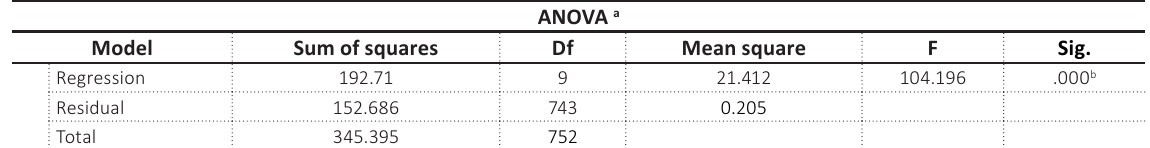
Table 9. Regression results